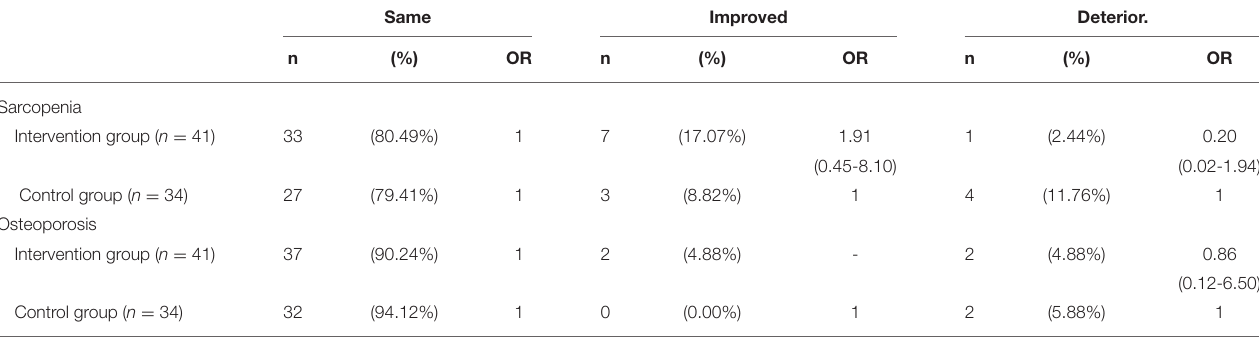
TABLE 4 | OR (95% CI) of sarcopenia and osteoporosis status in relation to intervention. Same Improved